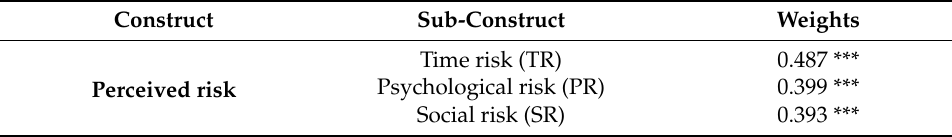
Table 4. Second-order